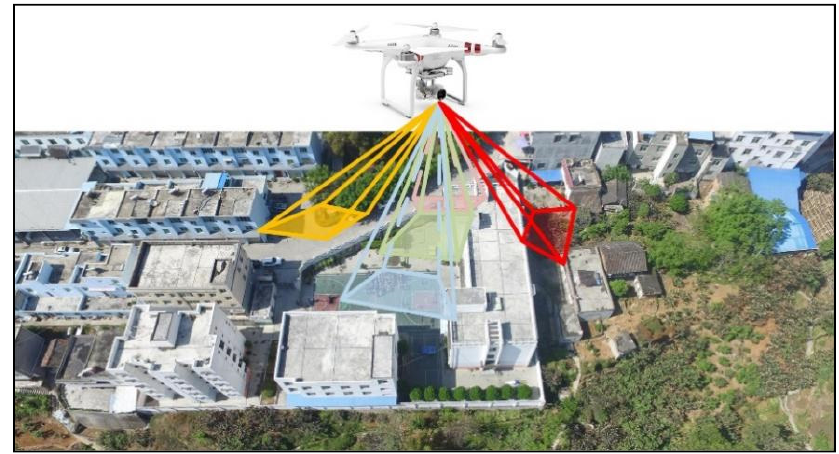
Figure 2. UAV oblique photography.